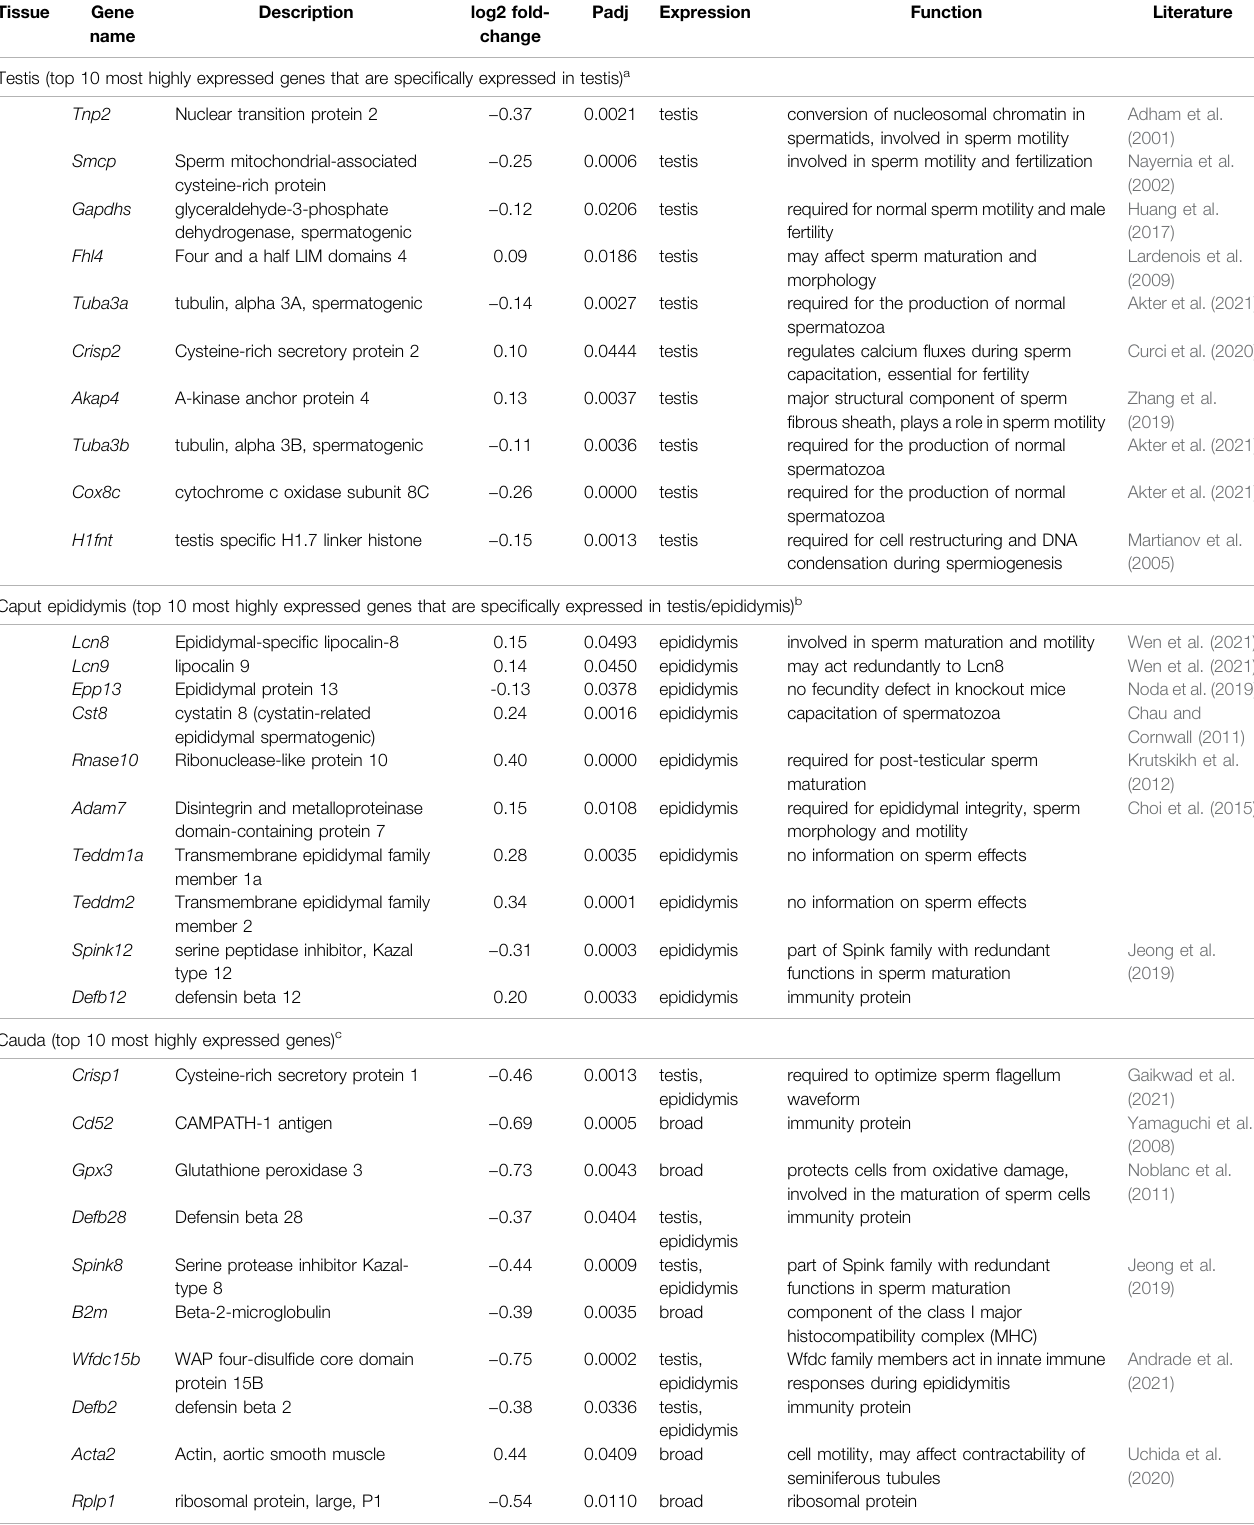
TABLE 2 | List of top signi fi cant genes in the RNASeq analysis for the three tissue samples. Named genes (i.e., predicted genes were not included) were retrieved from the DeSeq2 output ranked according to baseMean/mRNA length and expression characteristics (see Supplementary Table S1 for full results).